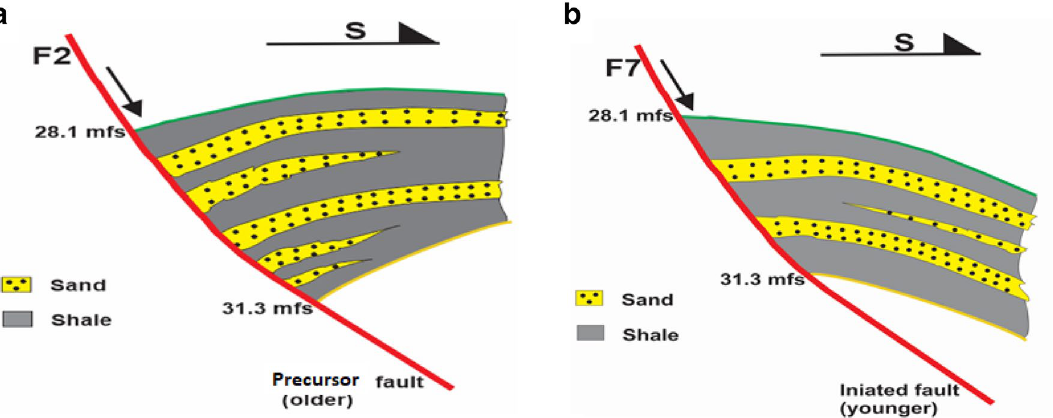
Fig. 21 a Precursor fault and associated facies change within sequence 28.1 MFS to 31.3 MFS, b initiated younger fault and associated facies change within sequence 28.1 MFS to 31.3